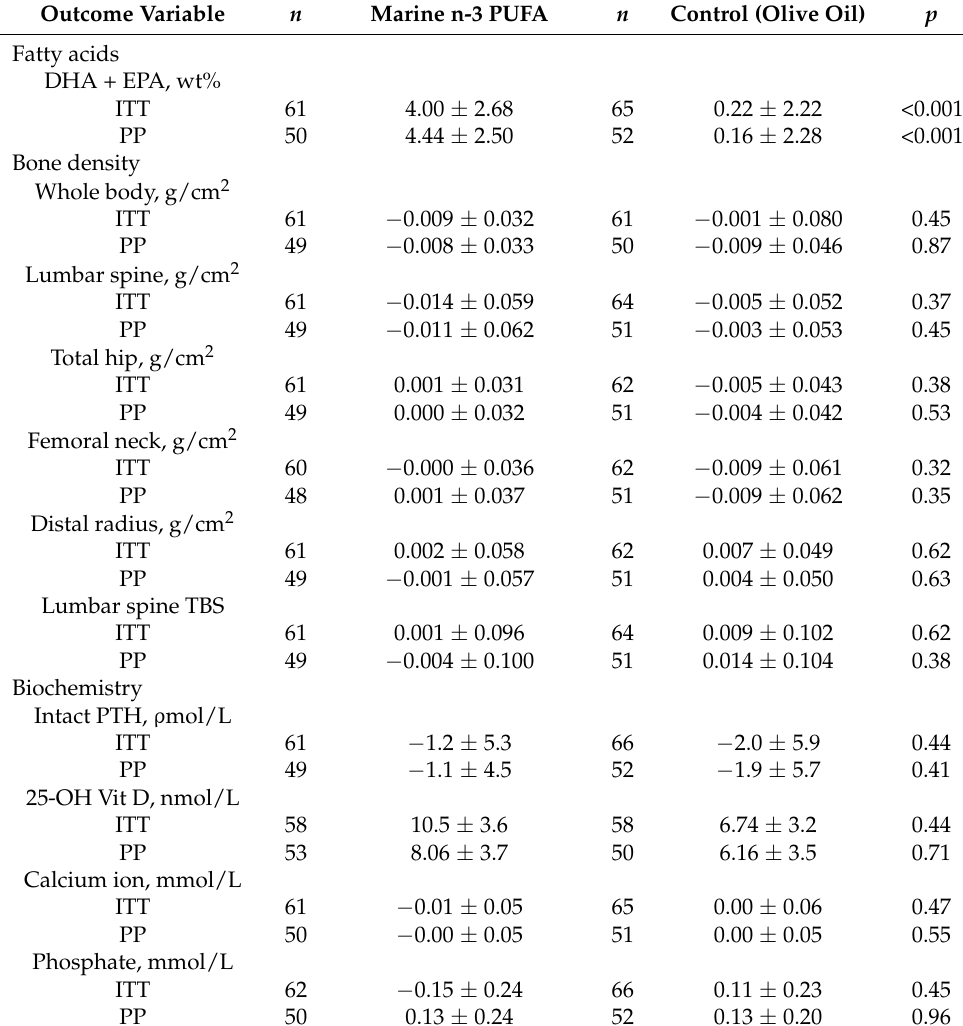
Table 2. Effects of marine n-3 polyunsaturated fatty acid supplementation on bone mineral density in adult kidney transplantation recipients, by intention to treat and per protocol